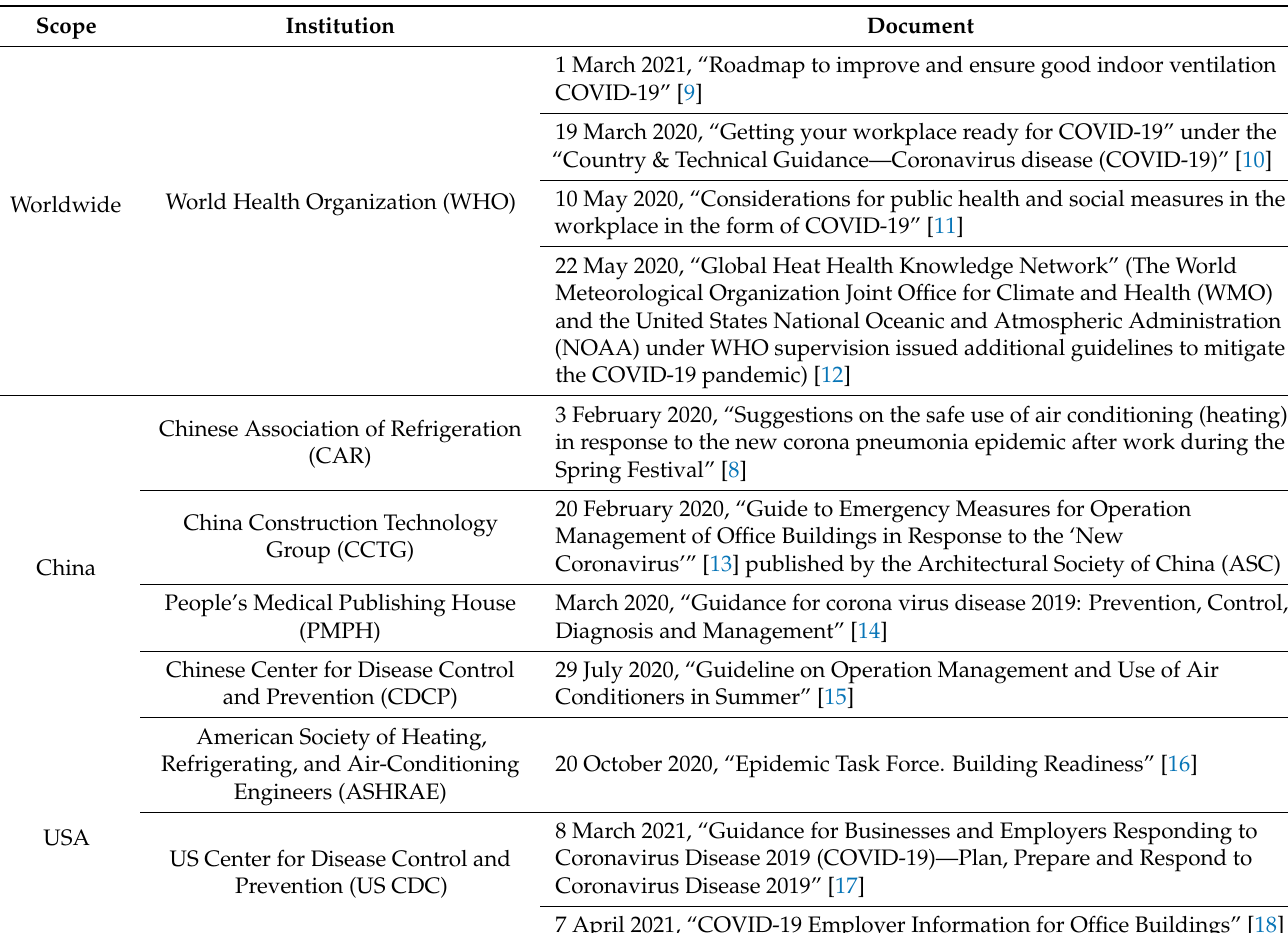
Table 1. Summary of the published COVID-19 guidelines issued by WHO, China, and the